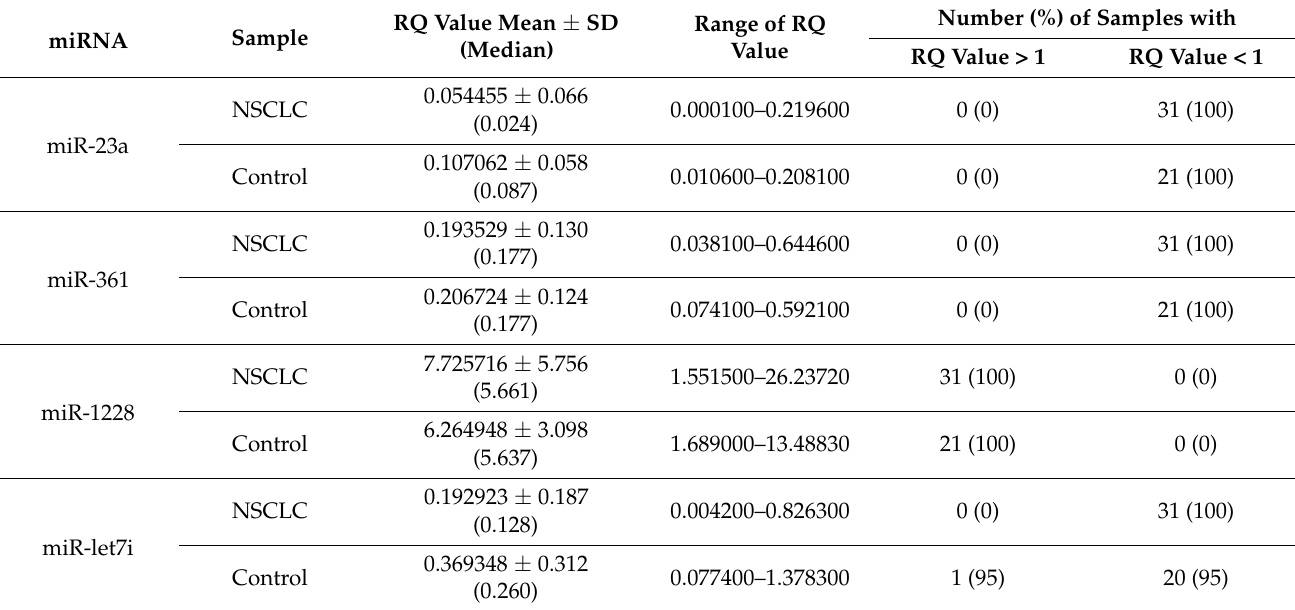
Table 2. RQ values for all studied miRNAs in serum EVs of patients with NSCLC and the control group.